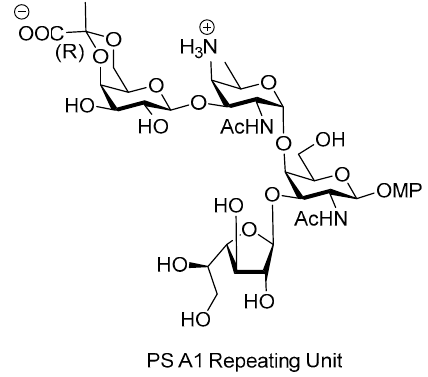
Figure 2. Structure of ZPS A1 with alternating charges on adjacent monosaccharides.